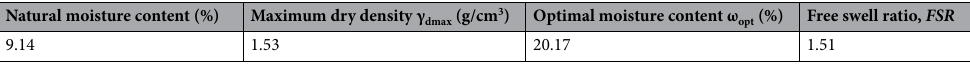
Table 1. Mechanical properties of the selected expansive soil.